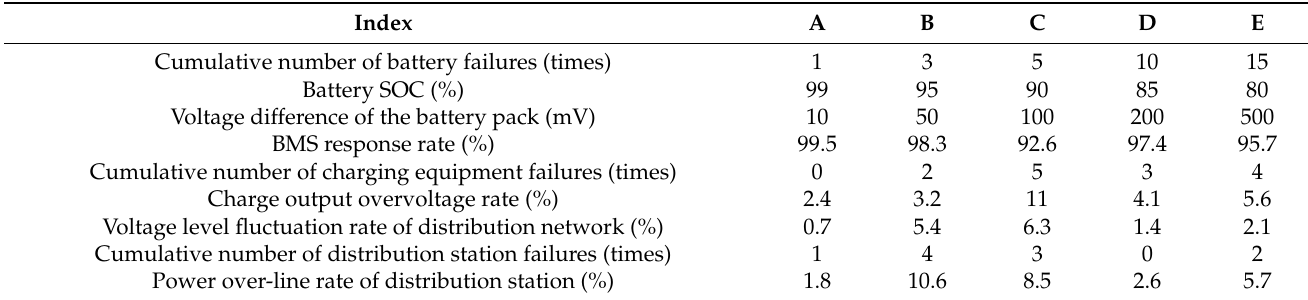
Table 4. Five groups of data of electric vehicle charging in a specific area of Nanjing in